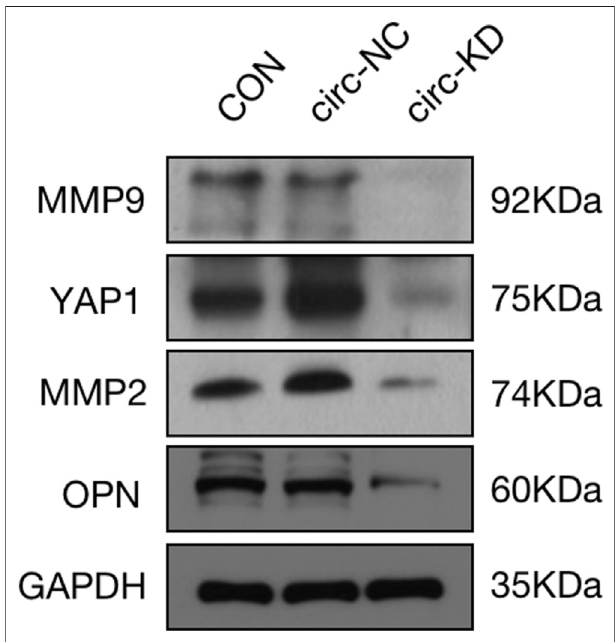
FIGURE15| ProteinexpressionlevelofMMP2,MMP9,YAP1,OPNand GAPDH assessed by western blot. GAPDH served as internal control. CON (cid:1) control,KD (cid:1) knockdown of hsa_circ_0005505, NC (cid:1) negative